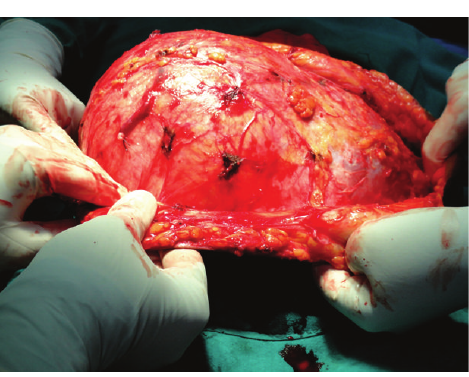
Figure 1: Preoperative image showing huge lump located in the anterior abdominal wall.